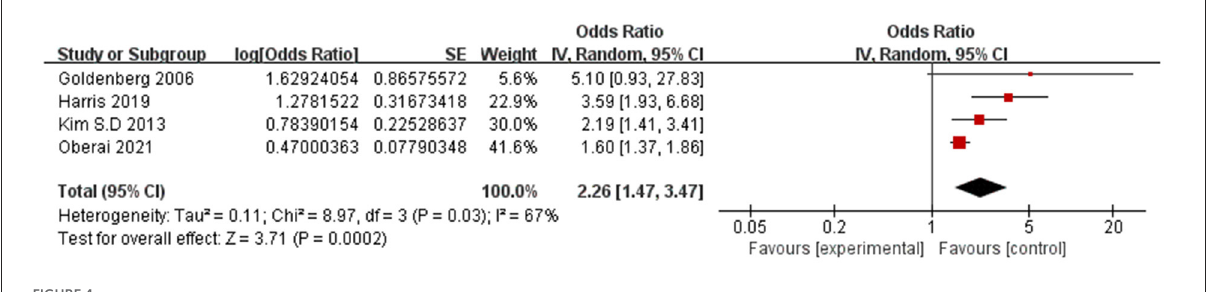
FIGURE4 Forest plot for age > 80 years.